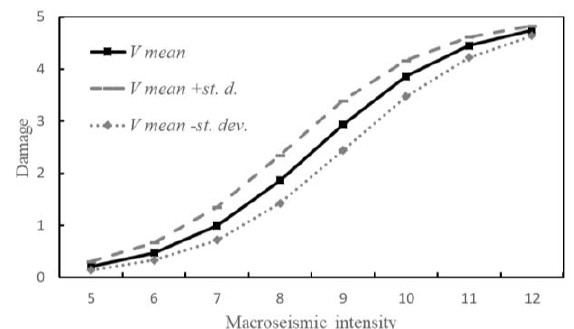
Figure 4. Vulnerability curve of the Scarperia urban stock.